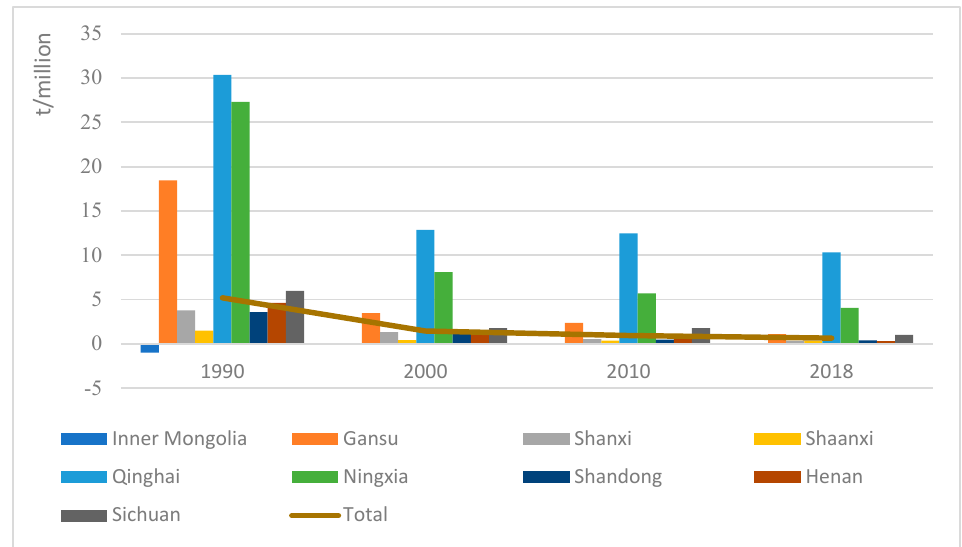
Figure 3. Carbon emission intensity per unit of GDP by province in different years in the study region (10 thousands t/CNY).